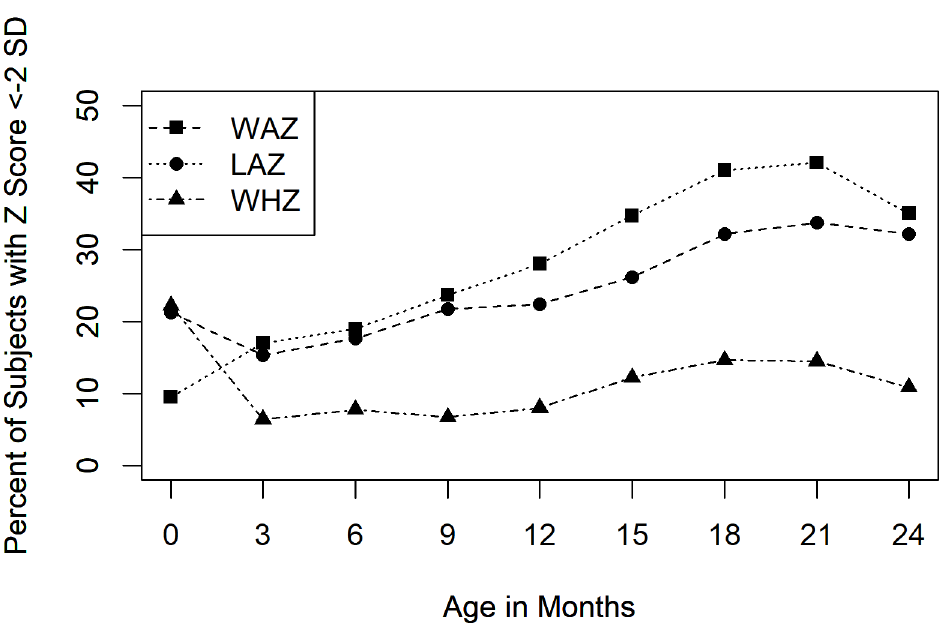
Fig 1. Anthropometry over the first 2 years of life for the 371 children with complete anthropometric measurements. Height and weight were taken at 3-month intervals and transformed to standardized Z scores. The X- axis depicts the child’s age while the Y-axis depicts the percentage of children in the cohort who had a LAZ, WAZ, or WHZ < -2